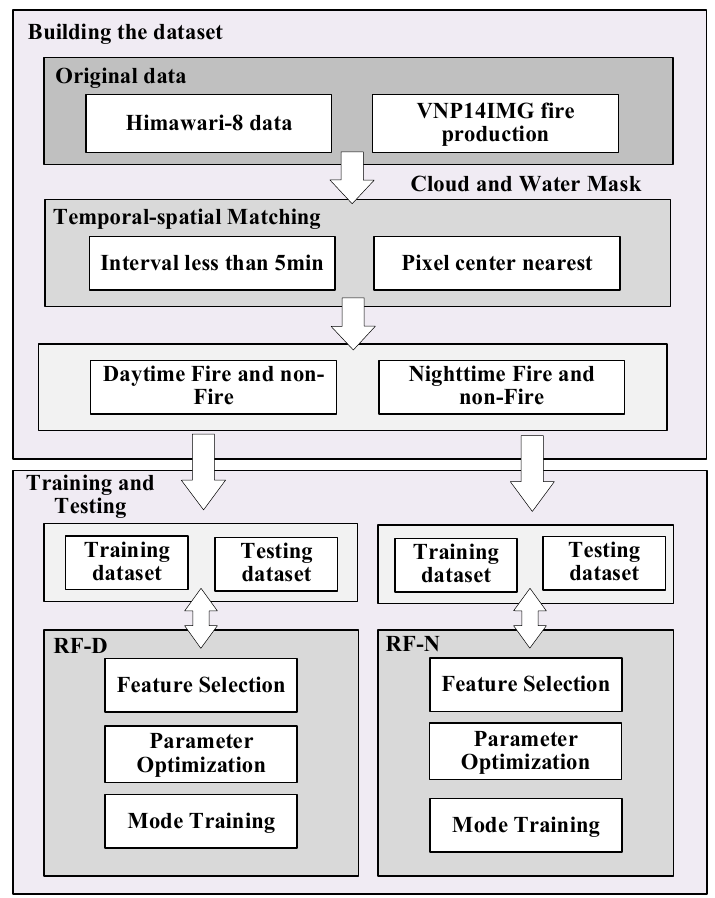
Figure 2. Flowchart for fire detection model construction.